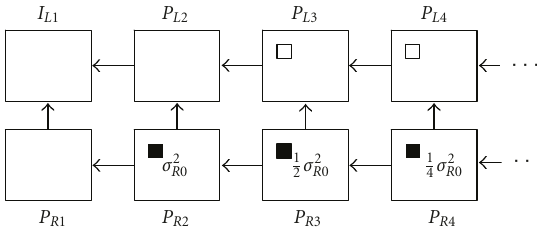
Figure 17: Propagation of an MB loss from R-frame.